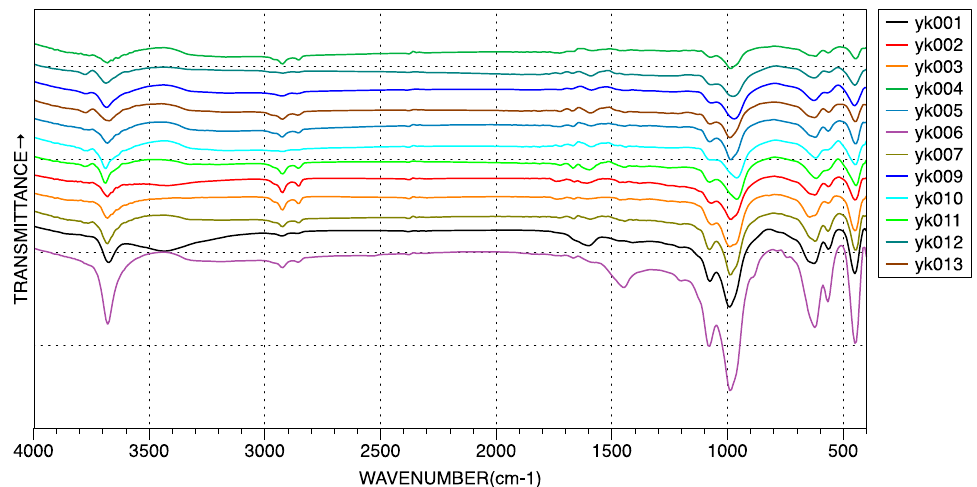
Figure 13. Raman spectra of serpentine samples in “Laoshan Jade”. Table 8. The main peaks and functional group attribution of serpentine samples in “Laoshan Jade”.